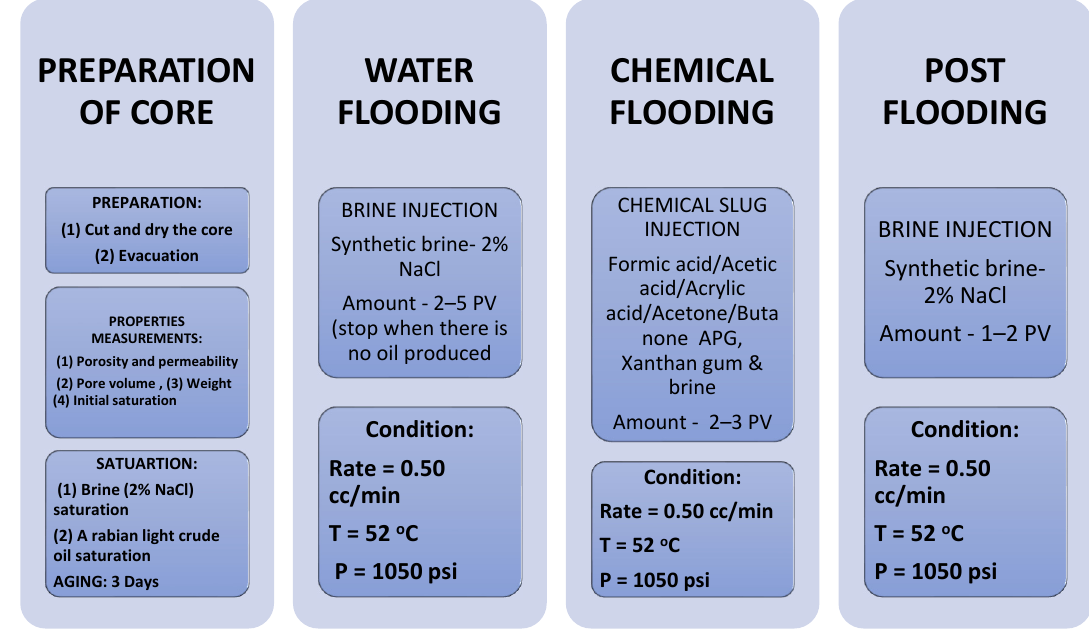
Figure 6. Core flooding procedure.